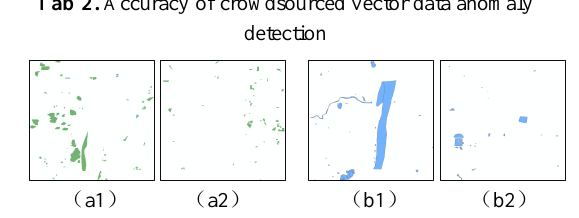
Fig 6. the results of OSM abnormal data detection. (a1), (b1) represent the normal OSM vector data of vegetation and water, (a2), (b2) represent the OSM abnormal vector data of vegetation and water, respectively.